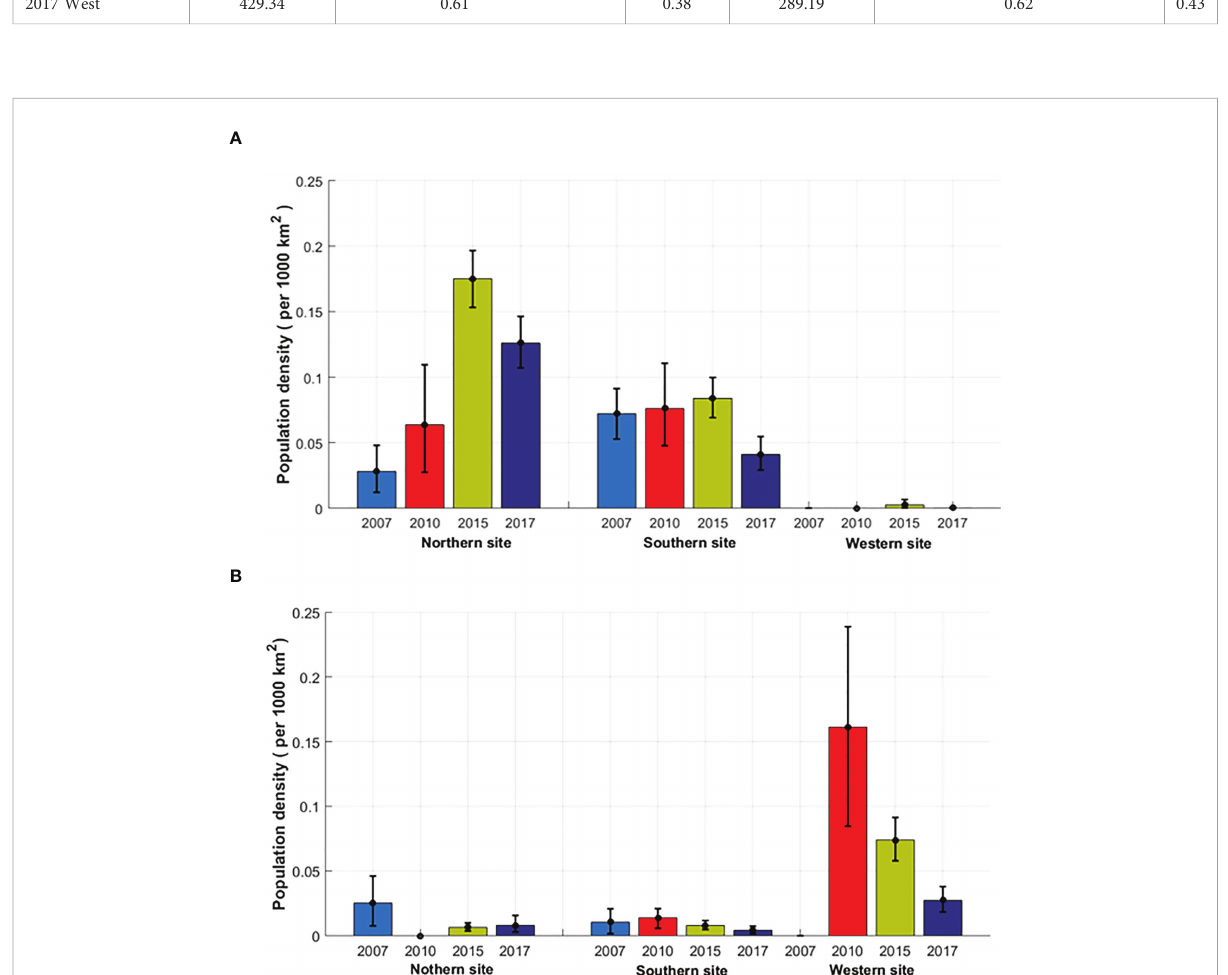
FIGURE 6 Mean and 95% con fi dence interval of the estimated density of (A) Cuvier ’ s and (B) Gervais ’ beaked whales.